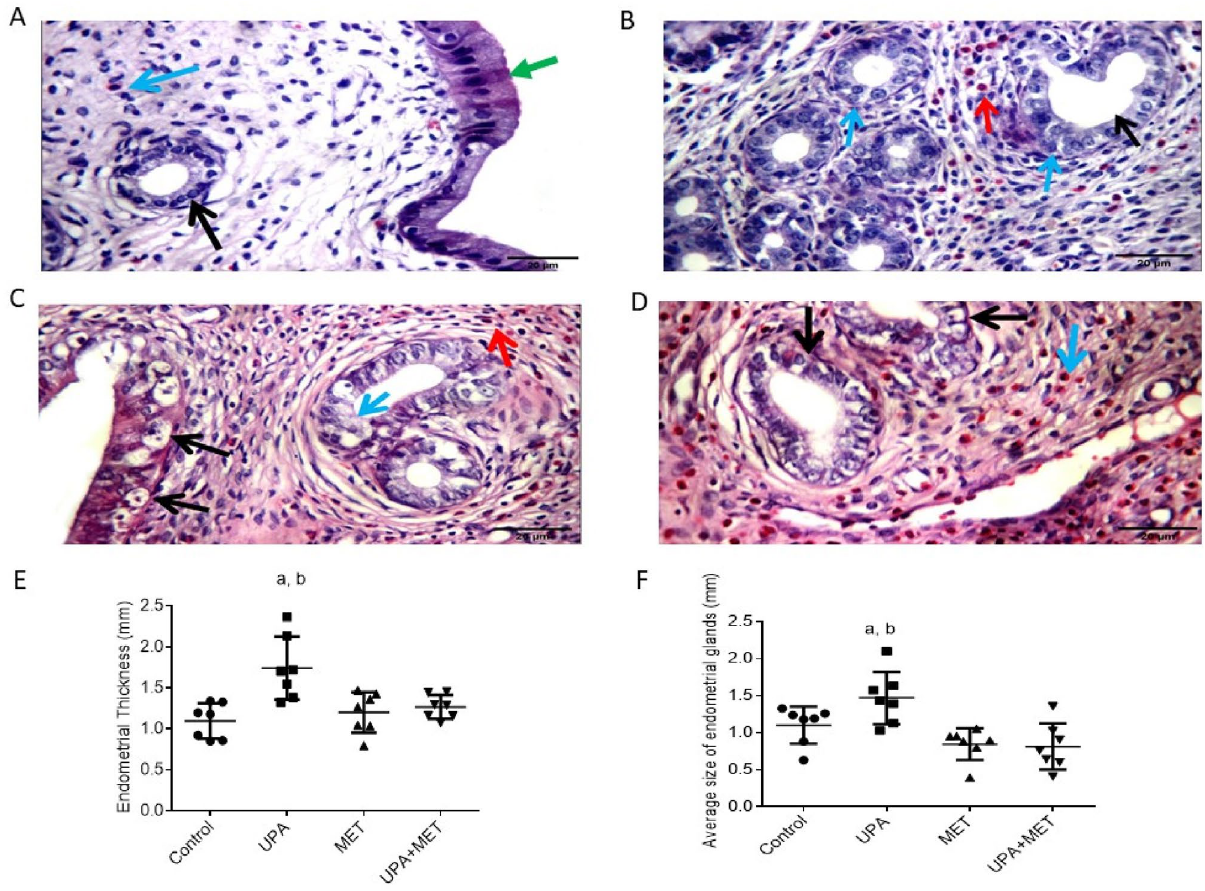
Figure 2. Representative images from each group of rats to demonstrate the histological examination of hematoxylin–eosin sections of rat uteri and the effect of ulipristal or/and metformin treatment on the rats’ endometrial thickness, glandular area. H&E × 400 magnification (scale bar = 20 μm). ( A ) Section taken from the uteri of the control group, the uterine wall showing average surface epithelium (green arrow) with uniform rounded endometrial gland (black arrow) in cellular stroma (blue arrow). ( B ) Section taken from the uteri wall of rats treated with UPA alone. It showed angulated and rounded glands (black arrow) with nuclear pseudo stratification (blue arrows) in compact cellular stroma showing excess eosinophils (red arrow). ( C ) Section taken from the uteri from metformin-treated rats, uterine wall showing variable-sized endometrial glands with sub nuclear (black arrows) and supra-nuclear secretory vacuoles (blue arrow) with excess stromal eosinophils (red arrow). ( D ) Section taken from rats co-treated with metformin and UPA, uterine wall showing uniform rounded endometrial glands lined by vacuolated cells (black arrows) in cellular stroma with excess eosinophils (blue arrow). ( E ) Effect of ulipristal or/and metformin treatment on the rats’ endometrial thickness. ( F ) Effect of ulipristal or/and metformin treatment on the rats’ glandular area. Data in figures ( E ) and ( F ) is represented by mean ± SD (n = 7). a or b, Statistically significant from the control or ulipristal & metformin treated group respectively at P < 0.05 using one-way ANOVA followed by Tukey as a post hoc test. UPA ulipristal, MET metformin, UPA + MET co-treatment with ulipristal and (Fig. 2A). Similarly, in the uteri from metformin-treated rats, the uterine wall showed average glandular/stro- mal ratio with equally distributed rounded endometrial glands with sub nuclear and supra-nuclear secretory vacuoles with excess stromal eosinophils, edematous stroma with average myometrium (Fig. 2C). In contrast, the uteri wall of rats treated with UPA alone showed hyperplasic changes, increased glandular/stromal ratio, variable-sized cystically dilated glands, compact cellular stroma with surface stromal edema, under developed spiral arterioles, excess eosinophils and average myometrium with congested blood vessels (Fig. 2B). In rats co- treated with metformin and UPA, the uteri wall showed average glandular/stromal ratio with equally distributed rounded endometrial glands, edematous stroma (Fig. 2D). Effect of ulipristal or/and metformin on rats endometrial thickness. The thickness of endome- trium, the vertical distance from the junction of endometrium and myometrium to uterine cavity, were deter- mined in rats from different treatment groups. In the normal control group or the group treated with metformin alone, the average endometrial thicknesses were 1.09 mm and 1.2 mm, respectively. While in rats treated with